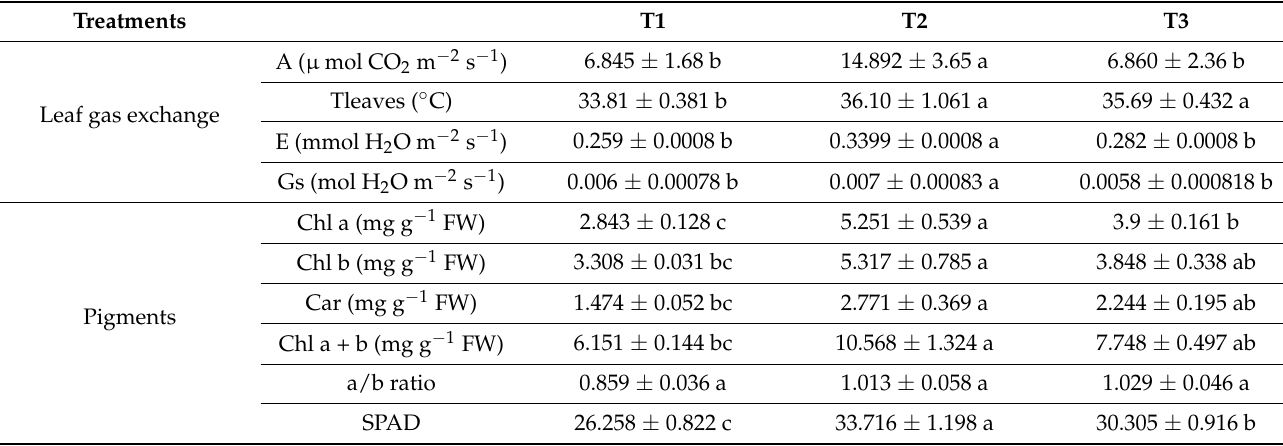
Table 1. The effects of the different shading levels on the leaf gas exchange and leave pigments of P. minus (data are means of treatments, N = 48; Rep = 4; Control, T1 = 0% Shading; T2 = 50% Shading and T3 = 70% Shading; FW = Fresh Weight; Means with different letters on top of each standard error of means are significantly different at p ≤ 0.05 between shading